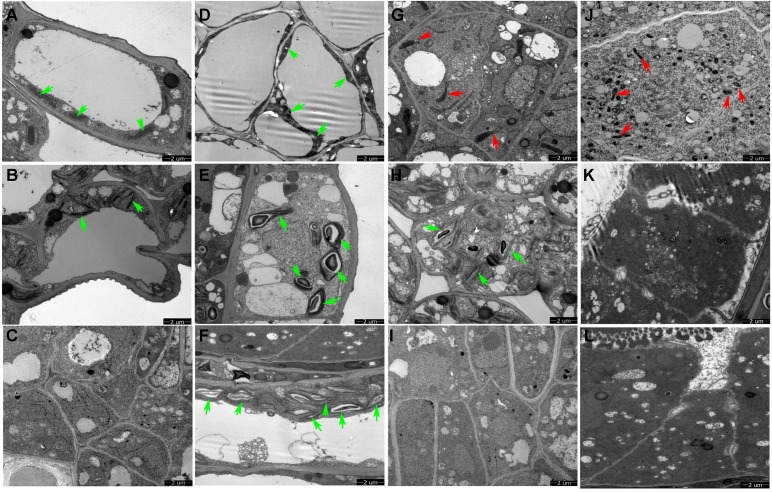
TEM observation of epidermis and tapetum cells of Shaan2A and Shaan2B anther walls. (A) Epidermis cells in 1 mm buds of Shaan2A. (B) Epidermis cells in 2 mm buds of Shaan2A. (C) Epidermis cells in 3 mm buds of Shaan2A. (D) Epidermis cells in 1 mm buds of Shaan2B. (E) Epidermis cells in 2 mm buds of Shaan2B. (F) Epidermis cells in 3 mm buds of Shaan2B. (G) Tapetum cells in 1 mm buds of Shaan2A. (H) Tapetum cells in 2 mm buds of Shaan2A. (I) Tapetum cells in 3 mm buds of Shaan2A. (J) Tapetum cells in 1 mm buds of Shaan2B. (K) Tapetum cells in 2 mm buds of Shaan2B. (L) Tapetum cells in 3 mm buds of Shaan2B. Green arrows indicate chloroplasts and red arrows represent mitochondria. Bar: 2 μm.